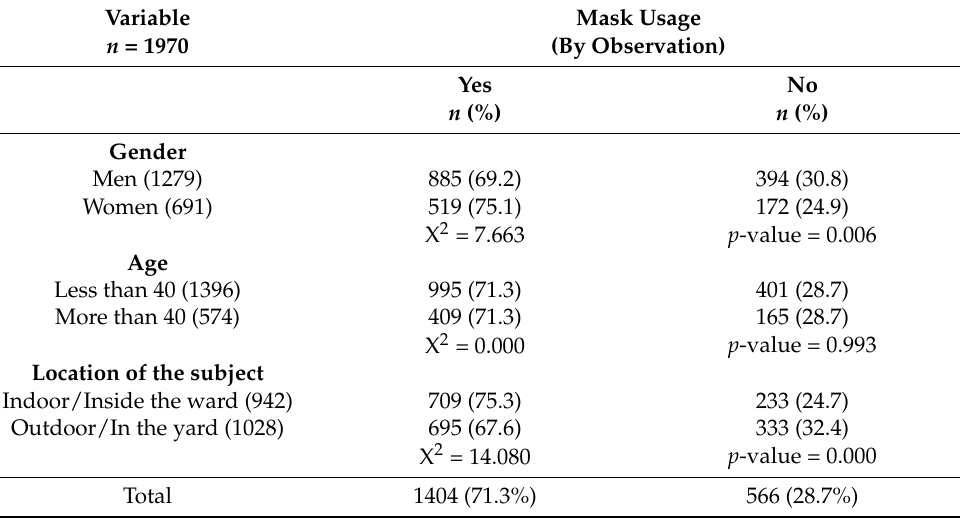
Table 3. Association between selected socio-demographic variables and mask usage among hospital